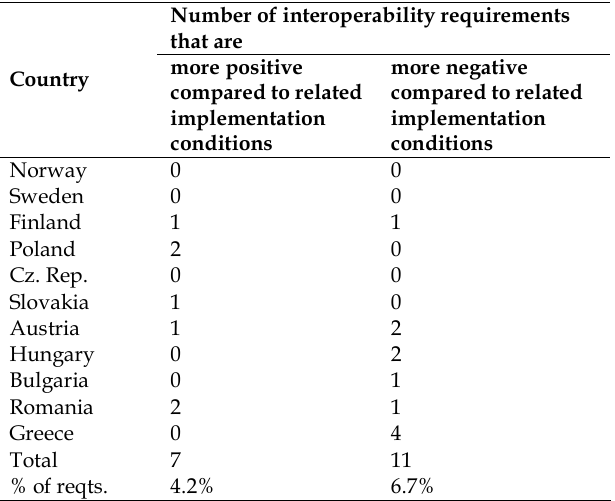
Table 7. Number of scores for interoperability requirements that are not explained by the statistical